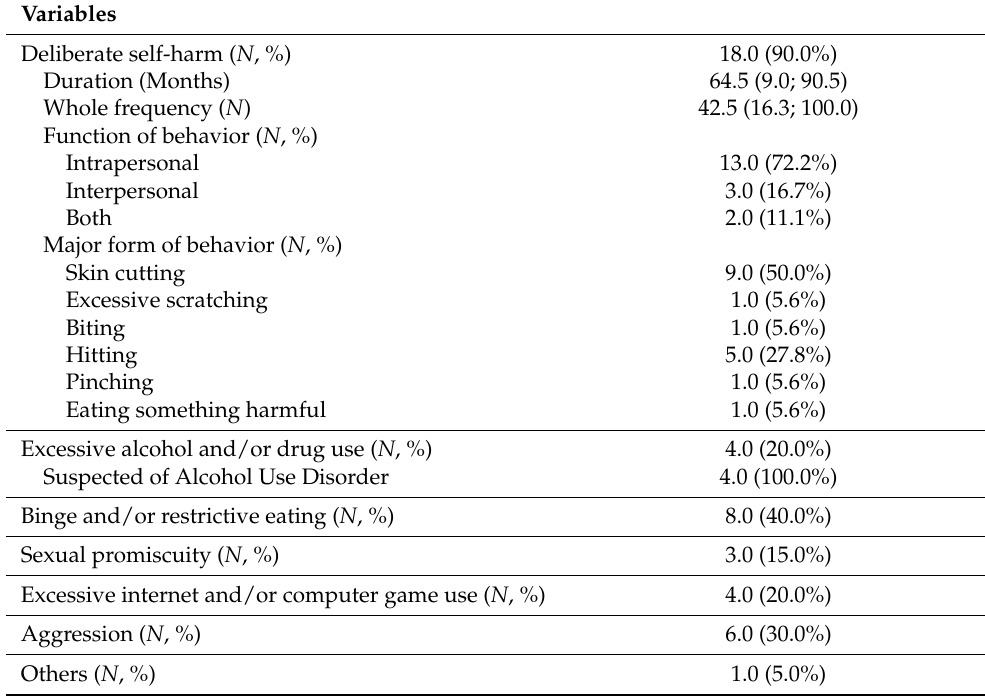
Figure 1. Participants by the number of their destructive experiential avoidance (DEA) behaviors. Table 2. Destructive experiential avoidance (DEA) within the past month (multiple